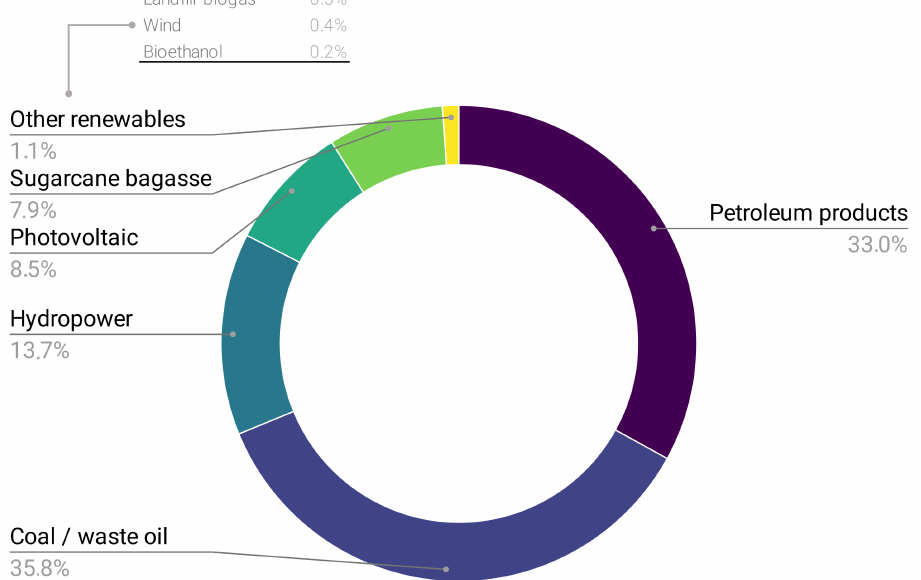
Figure 1. Electricity mix generation of Reunion island by sources, 2019, developed from data from